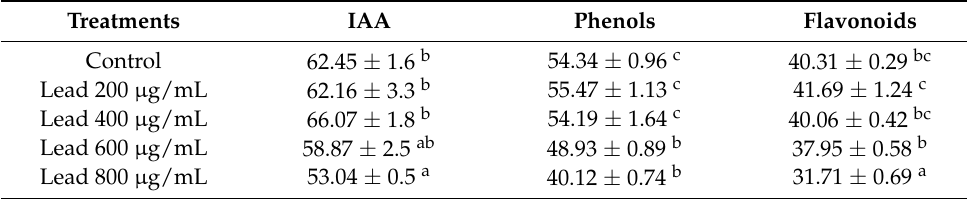
Table 1. Effect of lead stress on the secretion of IAA, phenols and flavonoids. Treatments